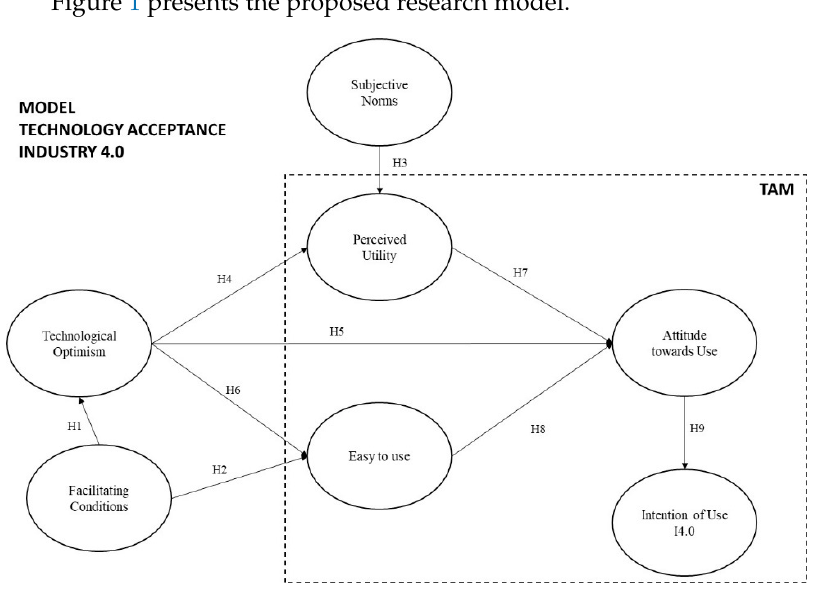
Figure 1. Research